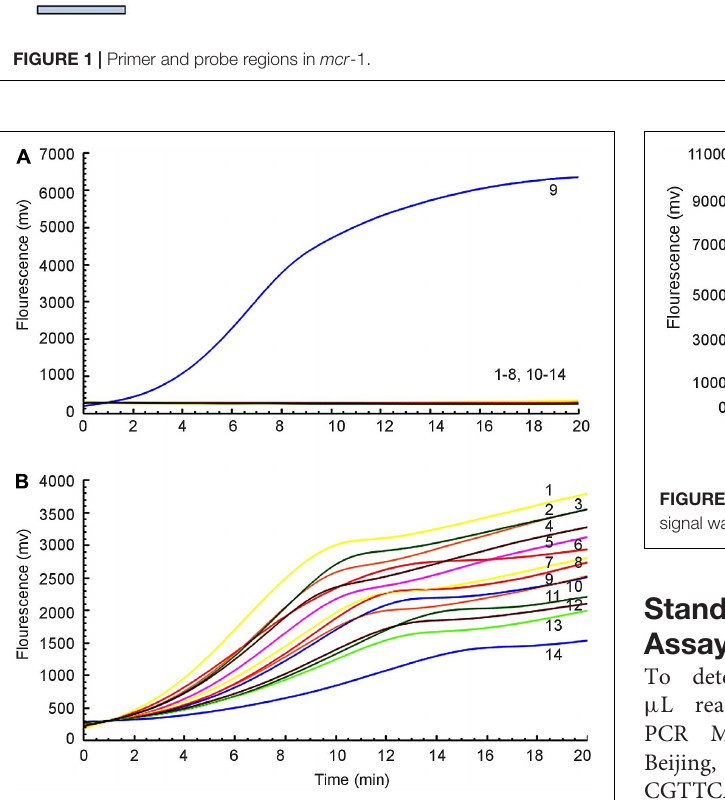
FIGURE 2 | Specificity of the RAA assay. (A) Amplification signal was only amplified from E. coli mcr − 1 , and no relevant signal was detected in other mcr -1-lacking strains. (B) All strains produced 16S rRNA gene amplification signals: 1: P. mirabilis , 2: K. pneumoniae 2146, 3: K. oxytoca , 4: